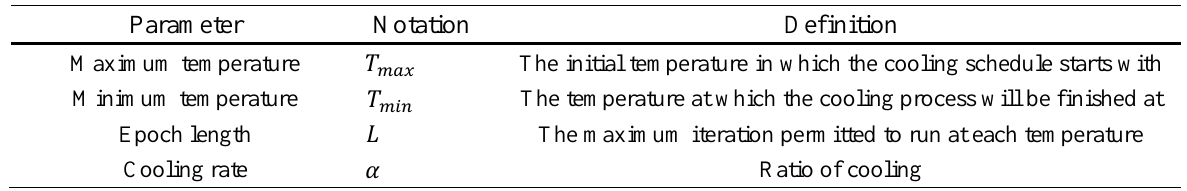
Table 4. Parameters of SA and each